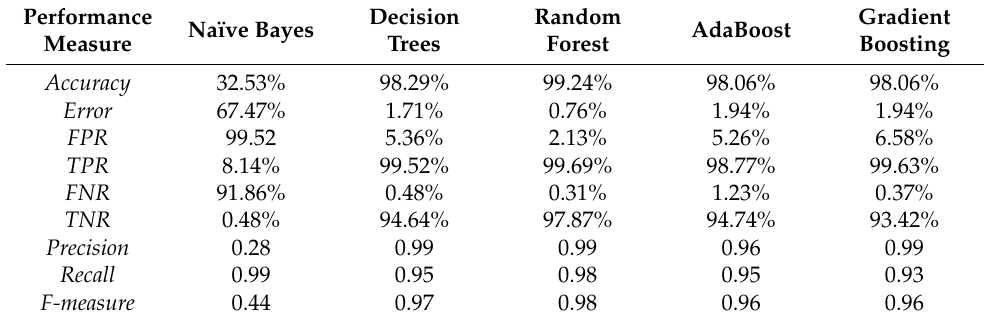
Table 3. Summary of results of machine learning